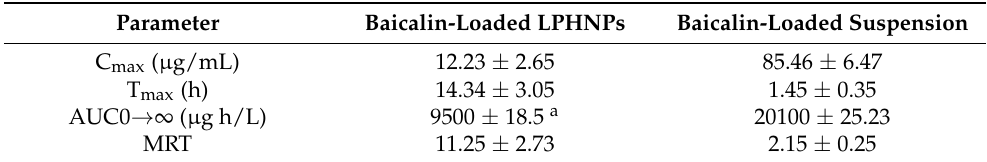
Table 3. Pharmacokinetic parameters of baicalin-loaded LPHNPs and baicalin suspension after oral administration in rats.